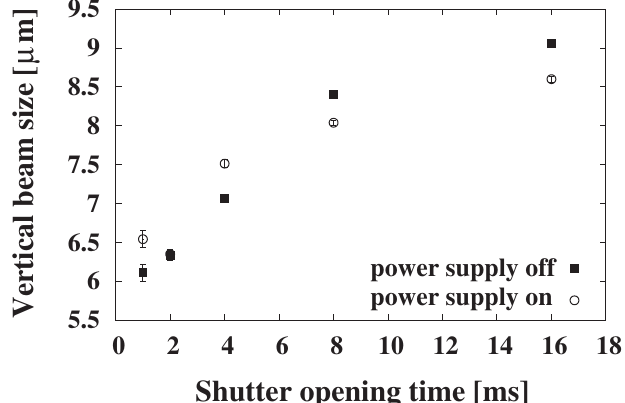
FIG. 15. Solid squares (open circles) showing the measure- ment of the vertical beam sizes as a function of the shutter opening time when the power supply of the Si crystal mono- chromator was turned off frequency up to 120 Hz. We found a 5 nm rms displace- ment of the CZP and 4 nm rms displacement of the MZP at 100 Hz frequency, as shown in Fig. 14. The scaled dis- placements at the source point due to the CZP and MZP displacements of (cid:1) y , are expressed as (cid:7) 1 (cid:8) 1 =M (cid:9) (cid:1) y , respectively. In our case ( M and (cid:7) 1 =M CZP (cid:3) 200 ), they are 11(cid:1) y and 10(cid:1) y . Assuming the and M MZP